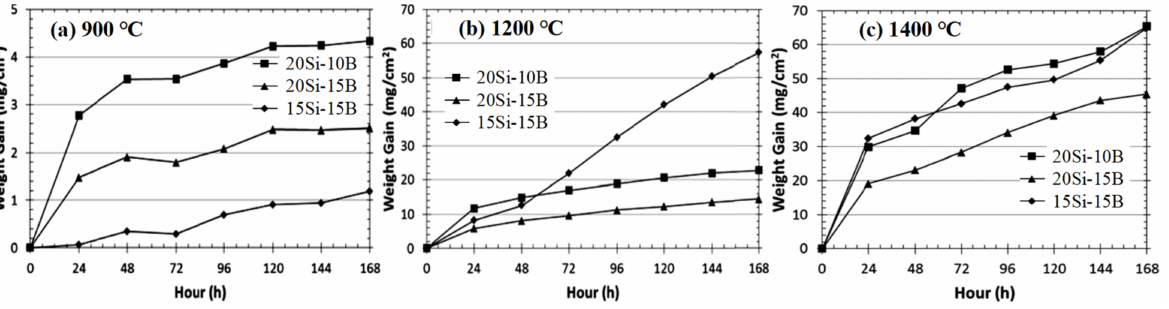
Figure 11. Long-term oxidation curves for alloys at ( a ) 900 ◦ C, ( b ) 1200 ◦ C, and ( c ) 1400 ◦ C. Copyright 2015